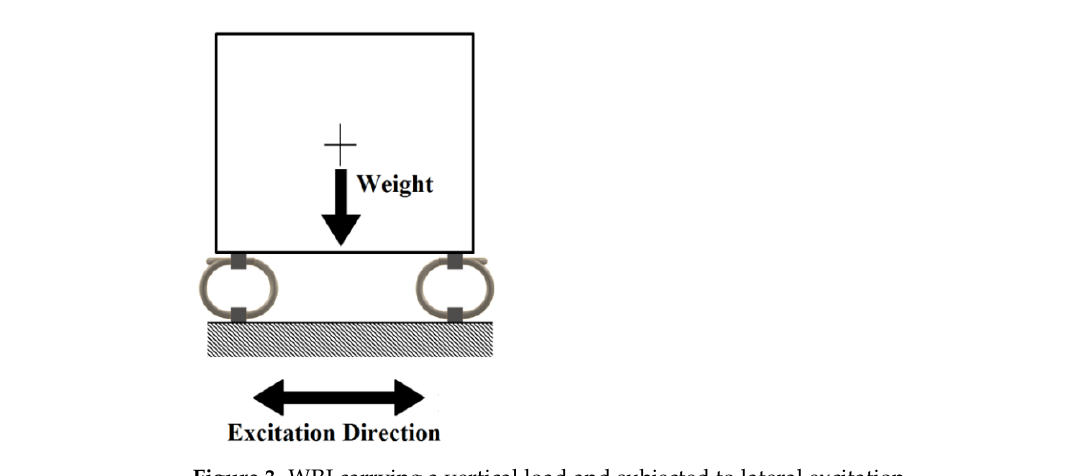
Table 2. Spring specifications.